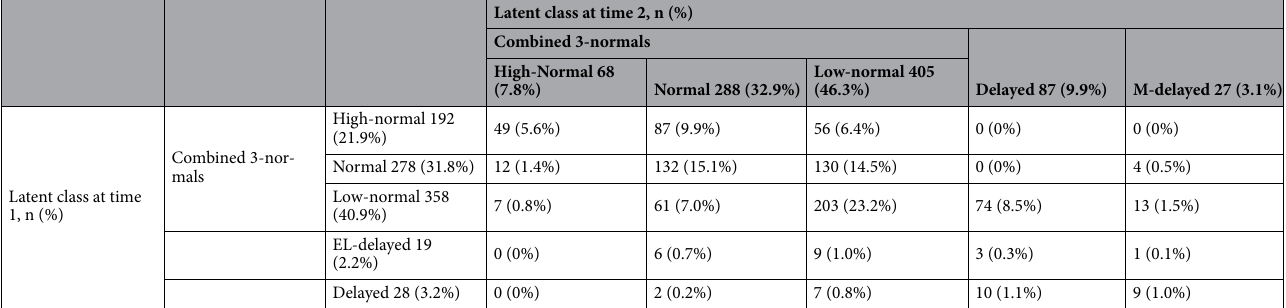
Table 2. Transition class counts and proportions derived by latent transition analysis ( n = 875). EL-delayed expressive language delayed, M-delayed markedly delayed.